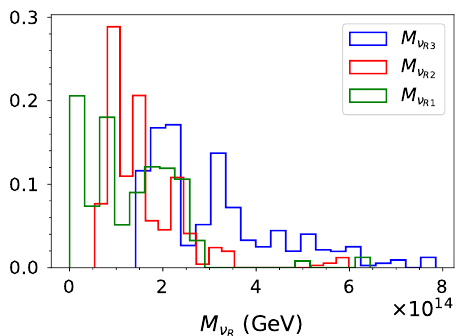
Figure 9 . Mass distribution of right handed neutrinos. Overall, the masses are very large and approximately of the same order of magnitude ( 10 14 GeV).